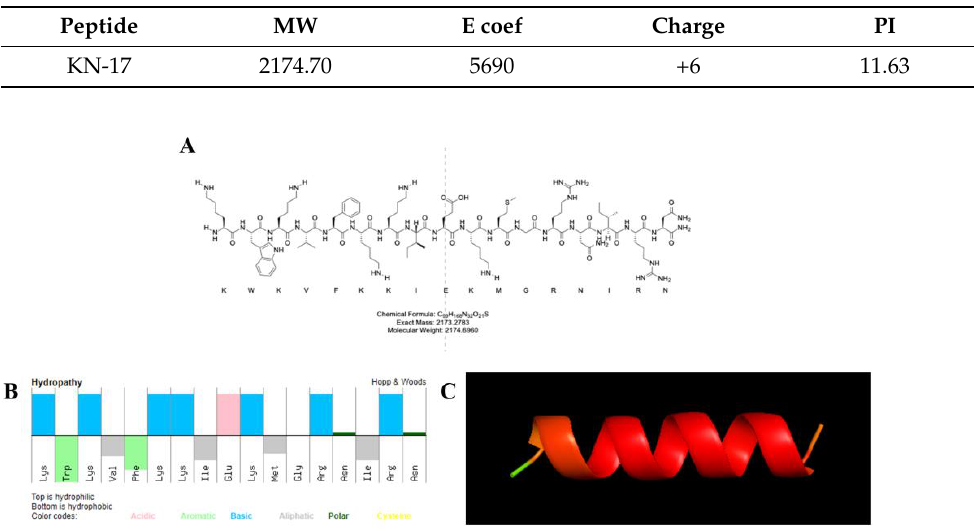
Figure 1. ( A ) Molecular structure formula of KN-17. ( B ) Molecular characteristics and physicochem- ical properties of amphiphilic peptide KN-17 (top: hydrophilic; bottom: hydrophobic). ( C ) Al- phafold predicted the tertiary structures of KN-17. predicted the tertiary structures of